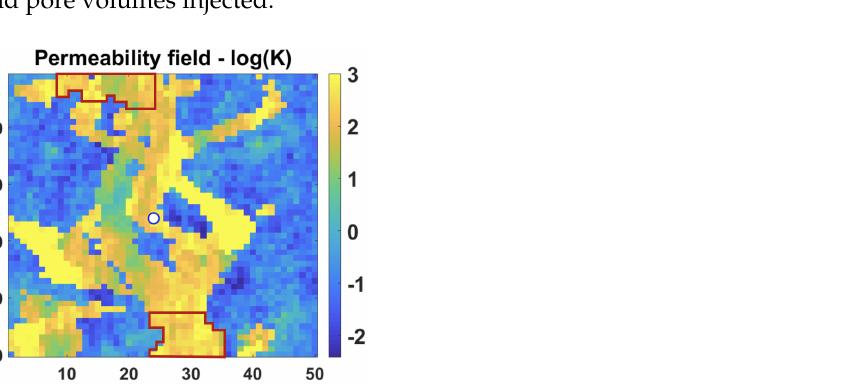
Figure 49. Reservoir model with an injector at location (24,26) and red regions showing the regions where the producer 1 (top of the reservoir) and producer 2 (bottom of the reservoir) locations are